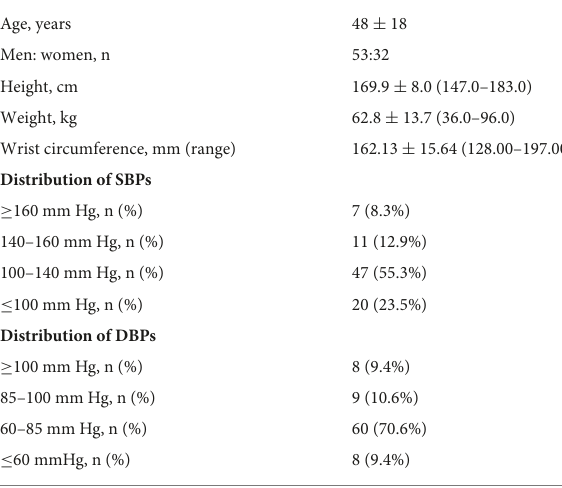
TABLE 1 Characteristics of the study participants.